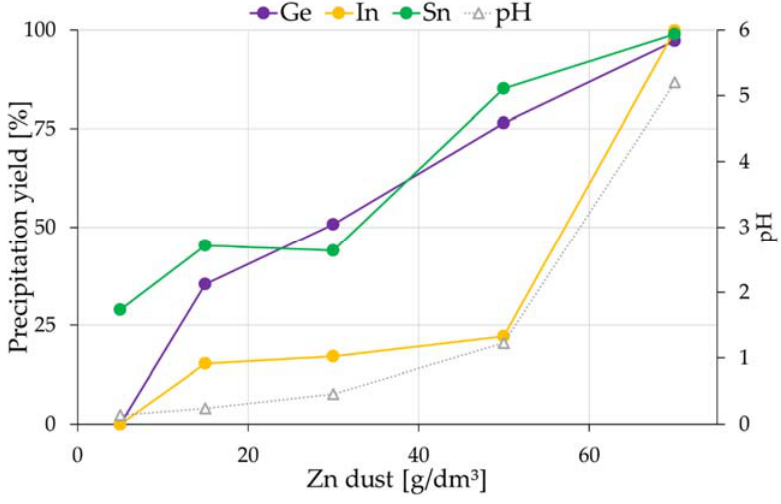
Figure 1. Influence of Zn dust amount on precipitation yields of Ge, In, and Sn, and final pH (60 °C, 2 h, 6 g/dm 3 Sn in initial solution).